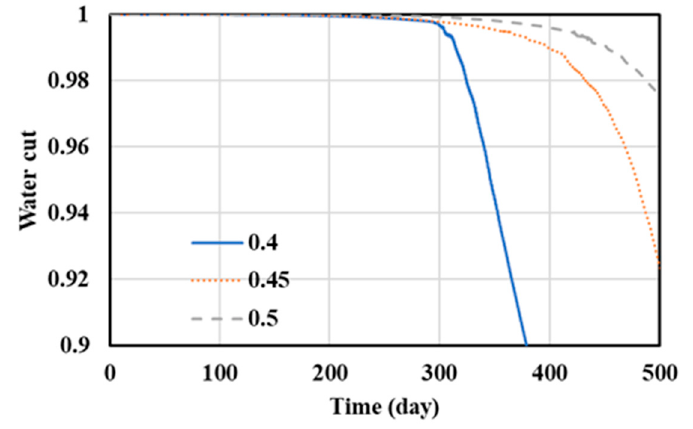
Figure 8. Water cut behaviors with different initial water saturations in the SRV region.